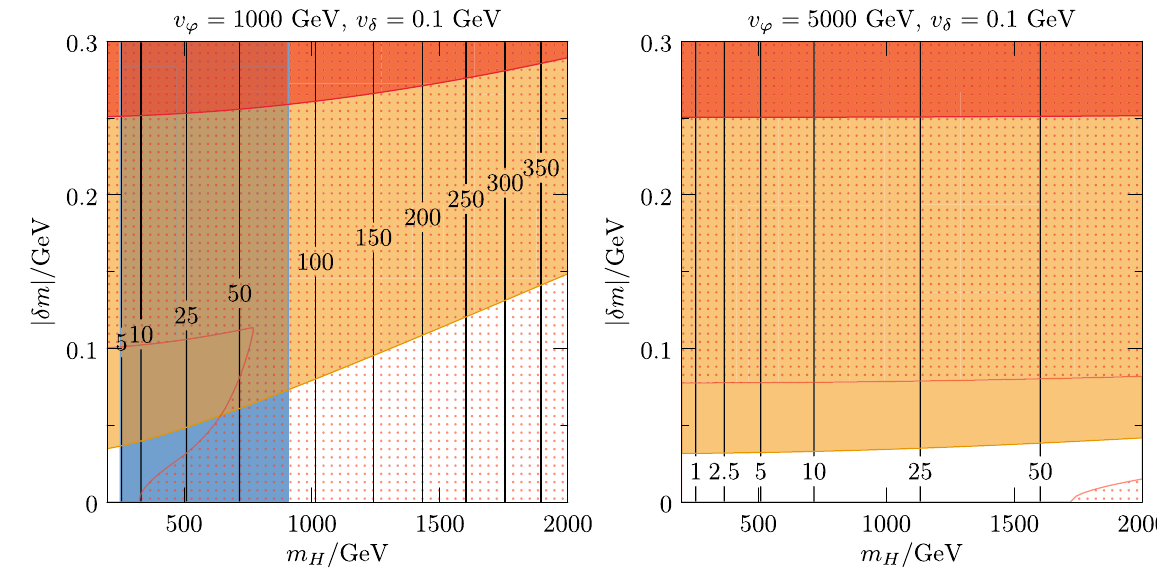
Fig. 2 The parameter space on the | δ m | vs. m H plane with v δ = 0 . 1 GeV and λ (cid:3) = 0 . 1. In the left panel, v ϕ = 1000 GeV; in the right panel, v ϕ = 5000 GeV. The black lines are contours of the dilaton mass m ϕ / GeV. The couplings are non-perturbative in the red region